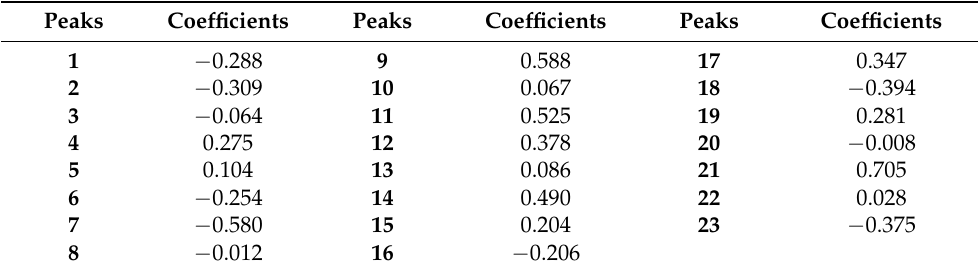
Table 6. Correlation coefficients of common peaks of partial least squares analysis. Peaks